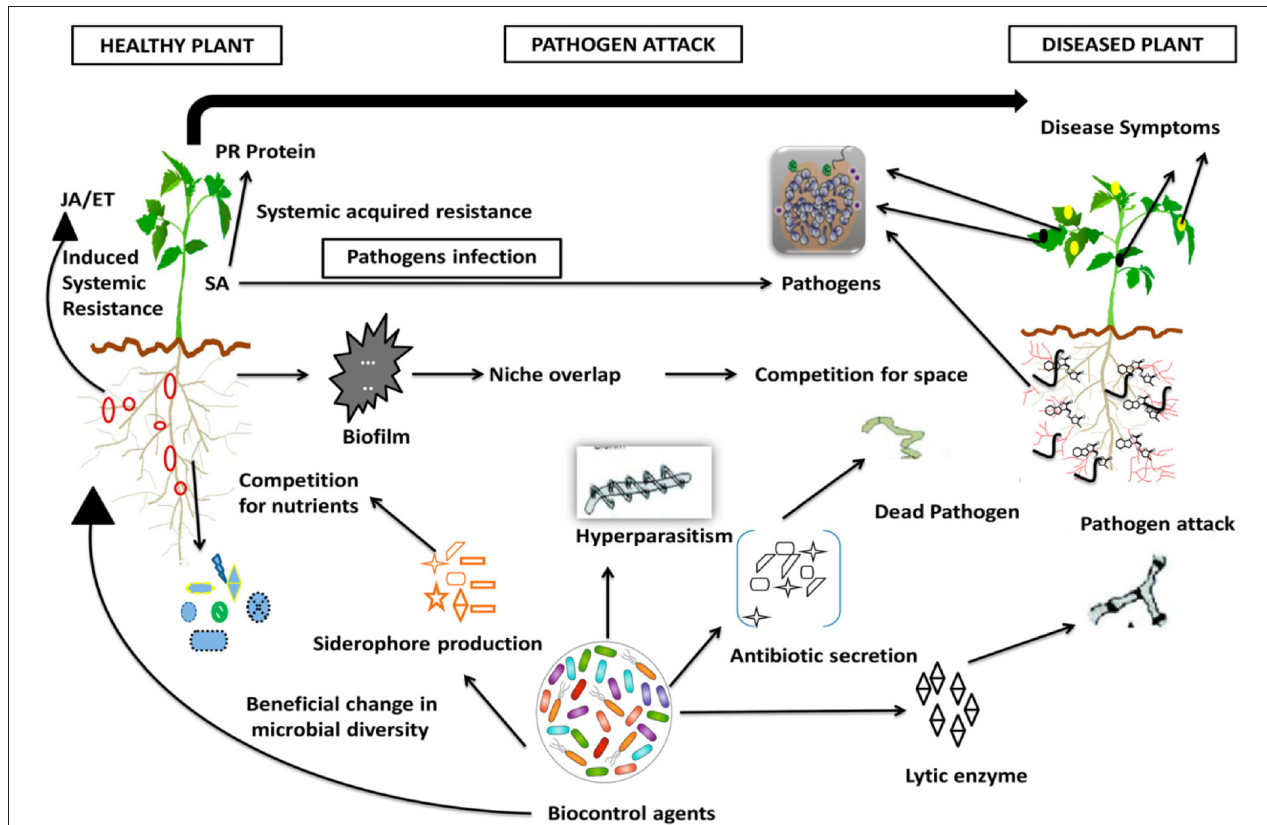
FIGURE 4 | Mechanism of biocontrol agent against pathogenic microorganism. Adapted from Tariq et al.